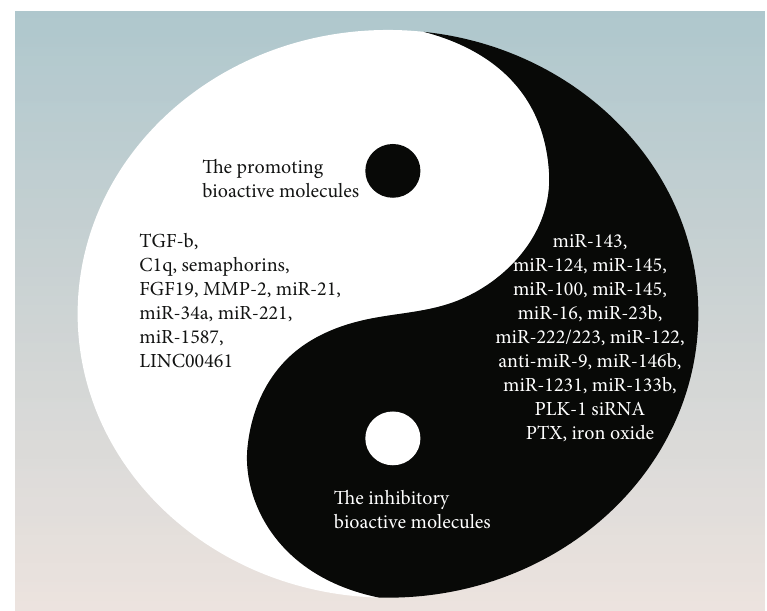
Figure 4: MSC-derived exosomes shuttle various bioactive molecules to inhibit or promote tumor growth. Black areas are inhibitory bioactive molecules, and white areas are promotional bioactive